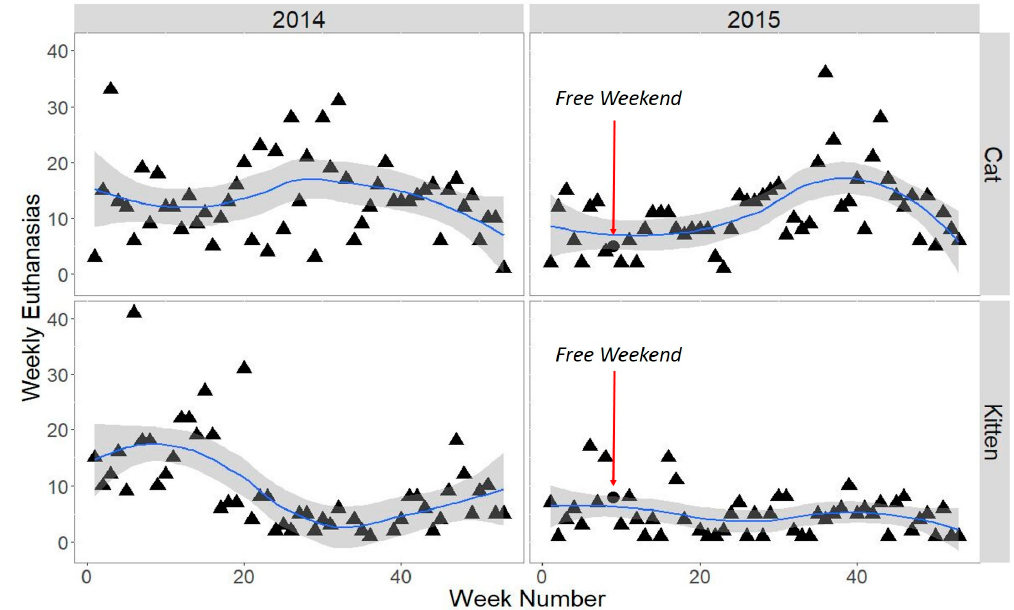
Figure 2. Weekly euthanasia rates for cats and kittens 2014–2015 at the Cat Haven, WA, with a loess smoother and 95% confidence envelope. The free weekend dot indicates the number of adult and mature cats or kittens euthanised during the entire week that included the adoption-drive.